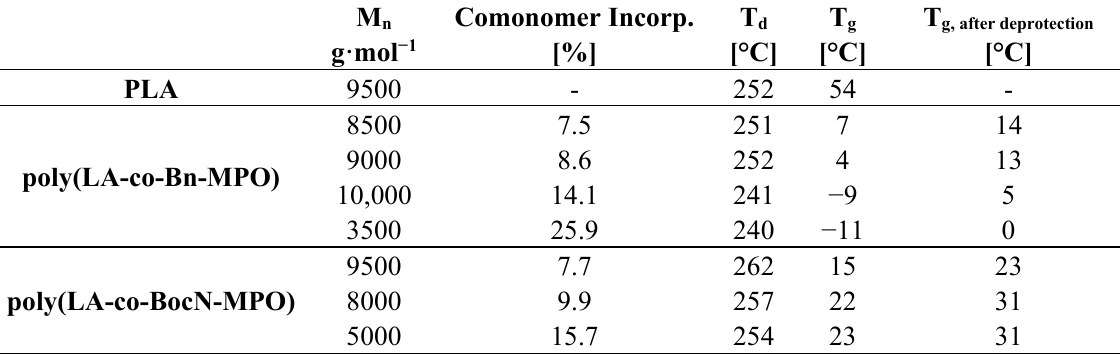
Table 1. Thermal properties of synthesized